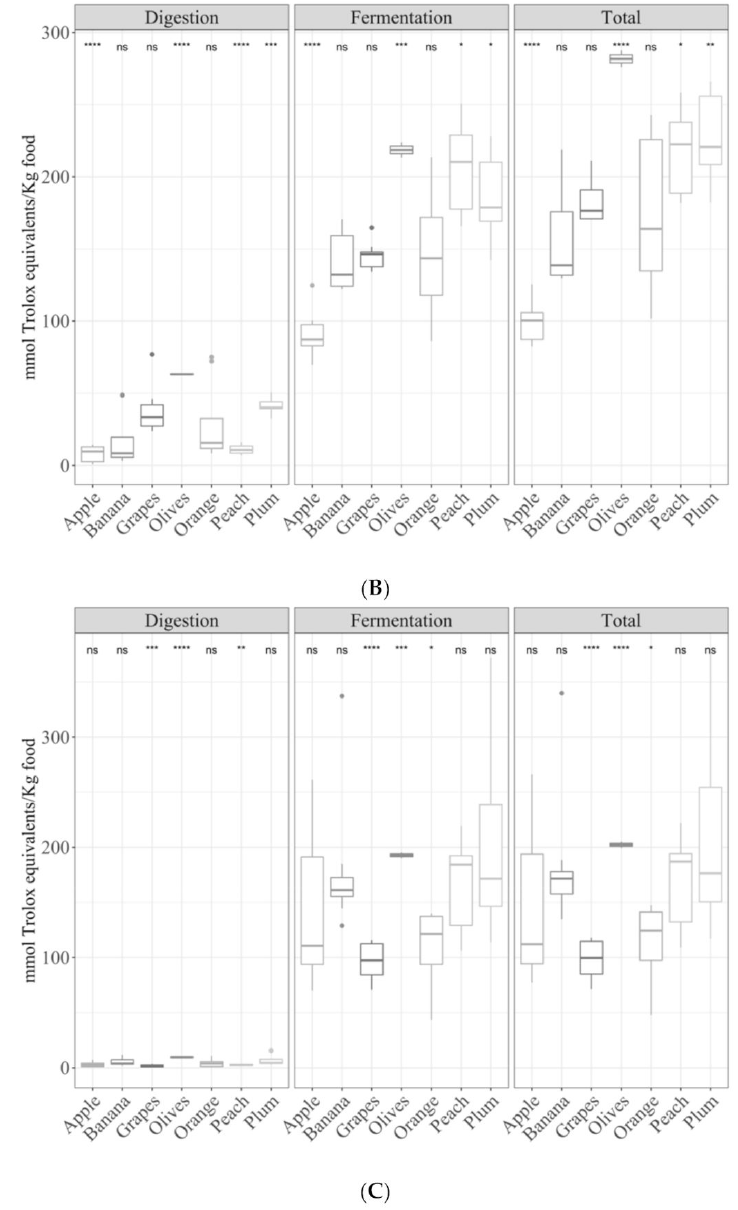
Figure 7. Antioxidant capacity of digested-fermented fruits depending on sample type (( A ) TEAC DPPH , ( B ) Folin–Ciocalteu and ( C ) for TEAC FRAP ). Statistical analysis was performed via ANOVA using the mean of all food groups as the reference group. Statistic labels: *: p < 0.05, **: p < 0.01, ***: p < 0.001, ****: p < 0.0001, ns: not